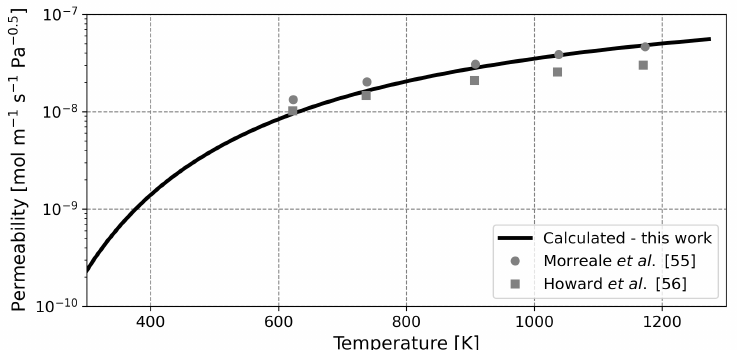
Figure 3. Comparison between calculated and experimentally obtained permeabilities for pure palla- dium. Different markers represent different studies and the line represents calculations. Experimental data from Morreale et al. and Howard et al.